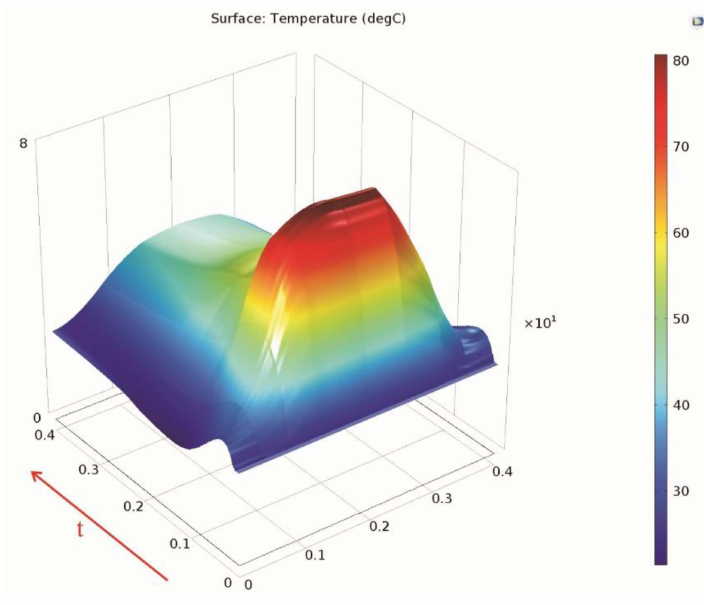
Figure 9. Temperature variation in time along the Cut Line 3D data set.